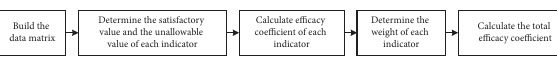
Figure 5: Efficacy coefficient method flowchart.